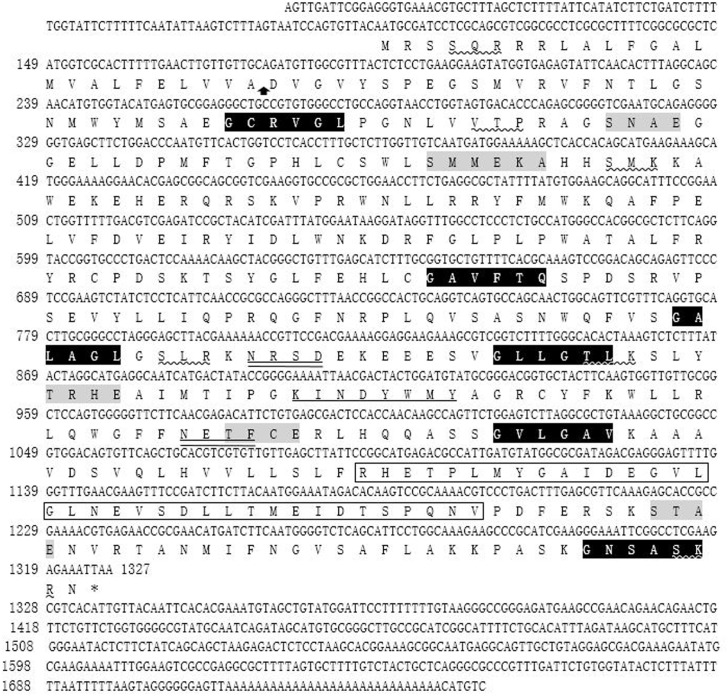
Nucleotide and predicted amino acid sequences of EtCHP559 gene.The stop codon is indicated with an asterisk. Putative N-glycosylation sites are double underlined. Putative protein kinase C phosphorylation sites are underlined by a wavy line. N-myristoylation sites are shaded black with white lettering. Casein kinaseII phosphorylation sites are shaded gray. Tyrosine kinase phosphorylation sites are underlined by a straight line. The vertical arrow indicates the cleavage site of the signal peptide. The ankyrin repeat is indicated by the black box.